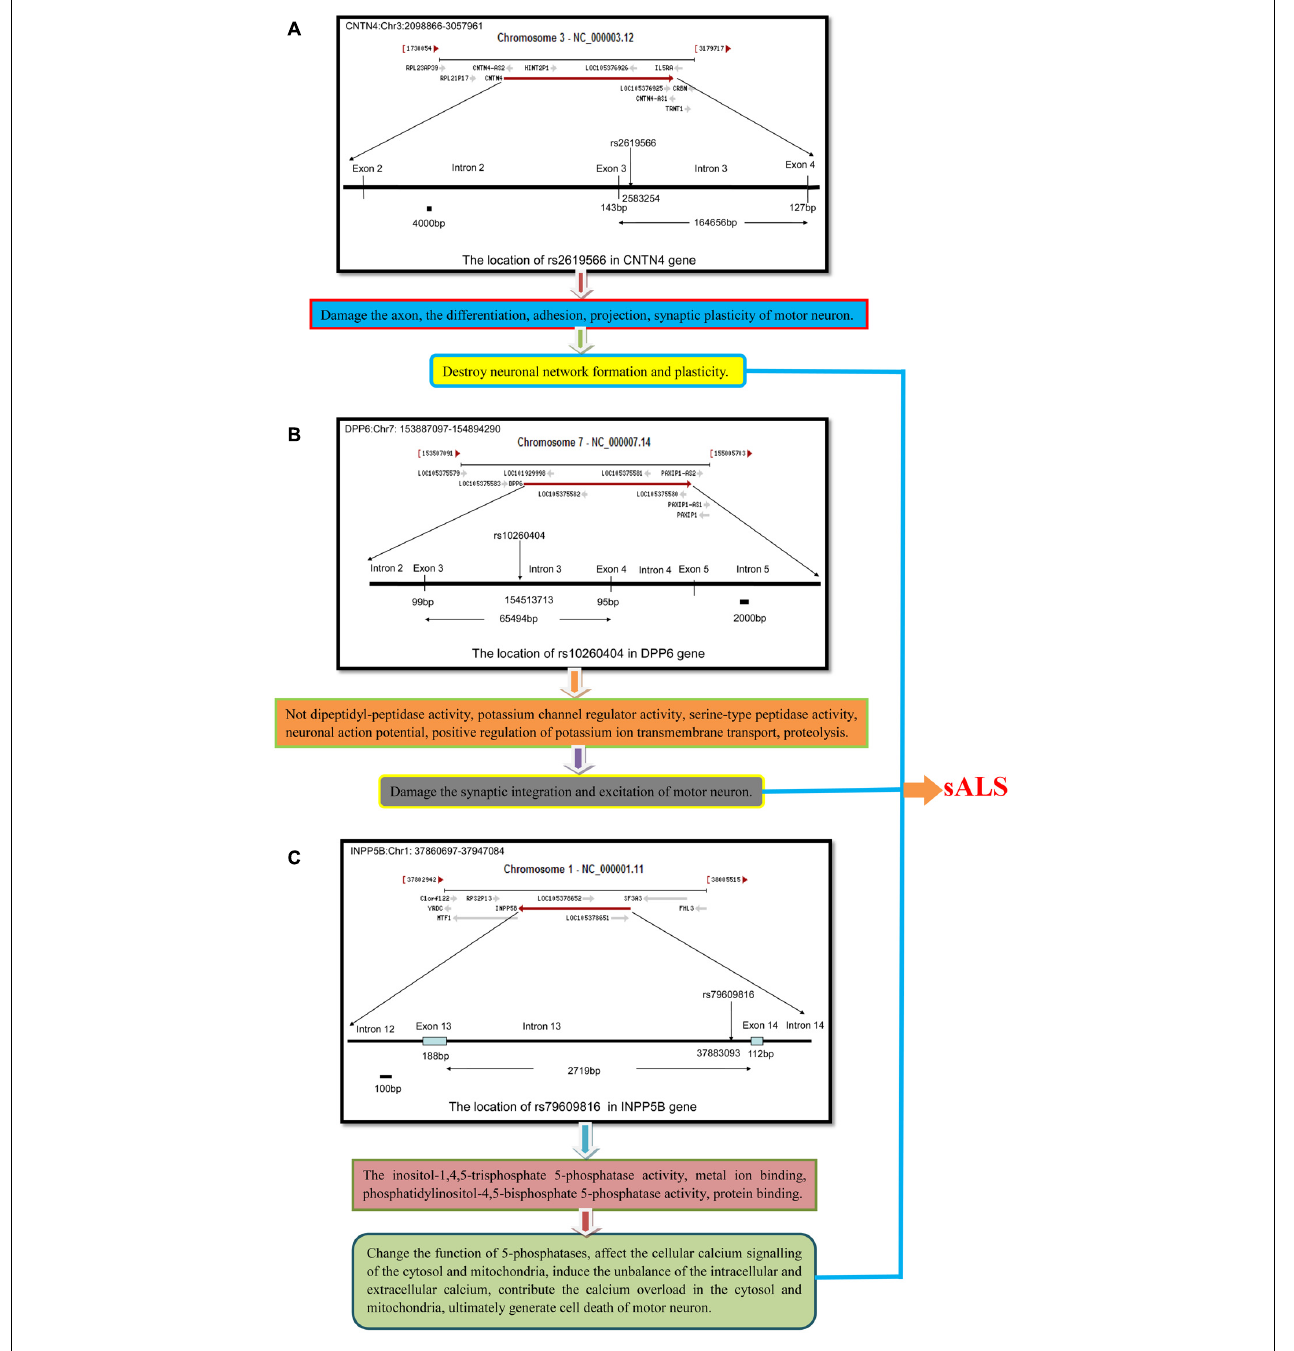
FIGURE 7 | The schematic diagram about the mechanisms that the polymorphisms of rs2619566 in CNTN4 , rs10260404 in DPP6 and rs79609816 in INPP5B might result in sALS from HACM. The pathogenesis of sALS might be a mechanism of multiple genes and loci participation through a series of complex pathophysiologic pathways. (A) The polymorphisms of rs2619566 in CNTN4 might be associated with destroy of neuronal network formation and plasticity. (B) The polymorphisms of rs10260404 in DPP6 might be related to damaging synaptic integration and excitation of neuron. (C) The polymorphisms of rs79609816 in INPP5B might induce the calcium disorder in cytosol and mitochondria, contributed to neuron death through a series of pathophysiological processes.